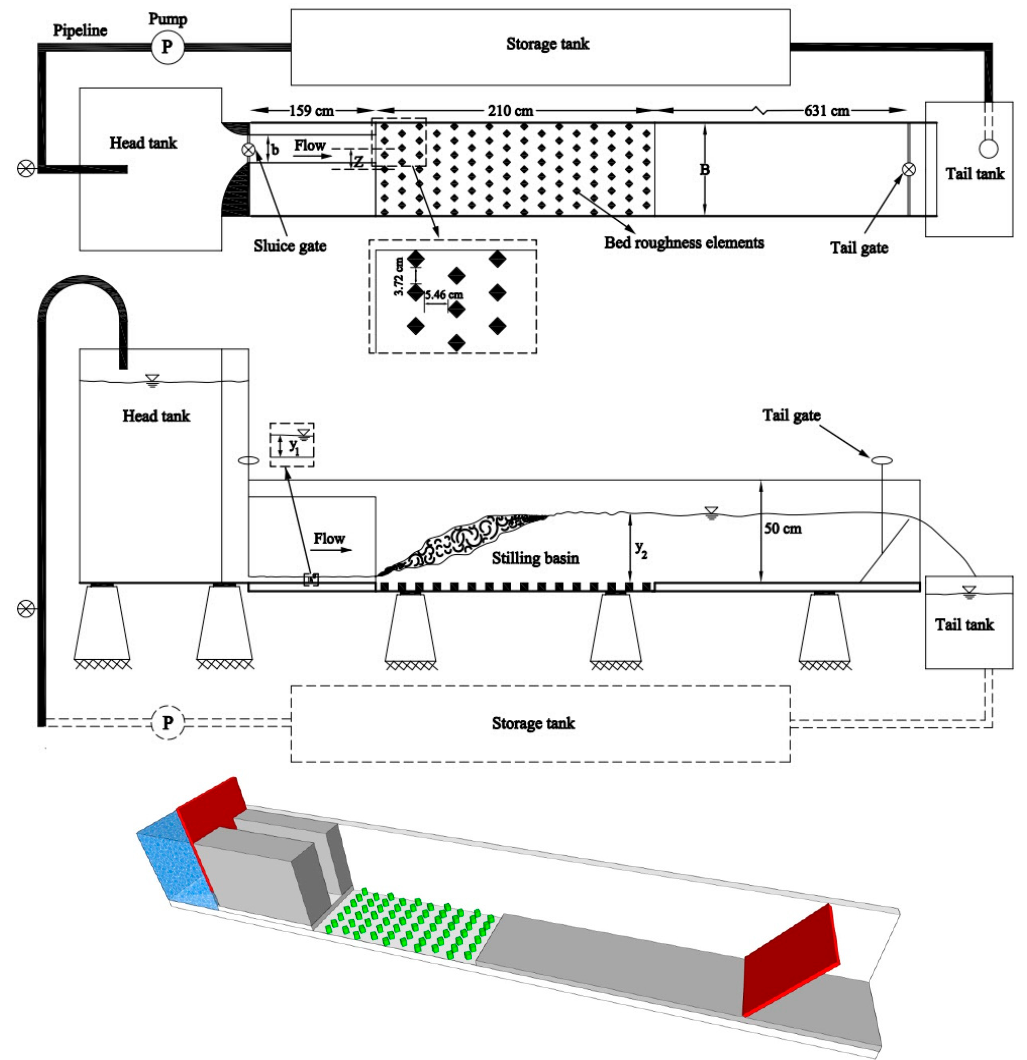
Figure 3. Plan, side, and 3D view of the experimental equipment and arrangement of the roughness